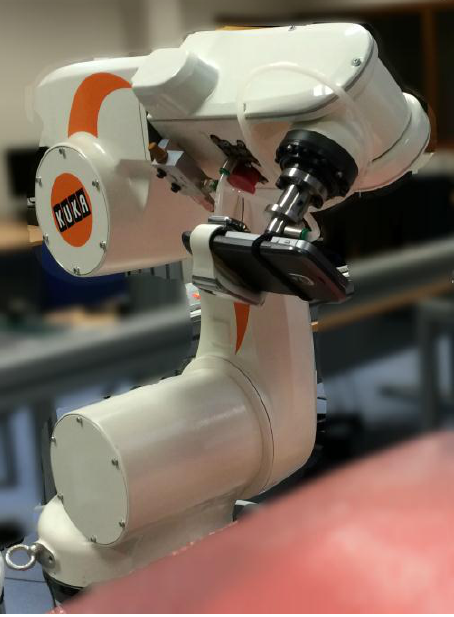
Figure 3. Picture showing the two smartphones superimposed mounted on the robotic